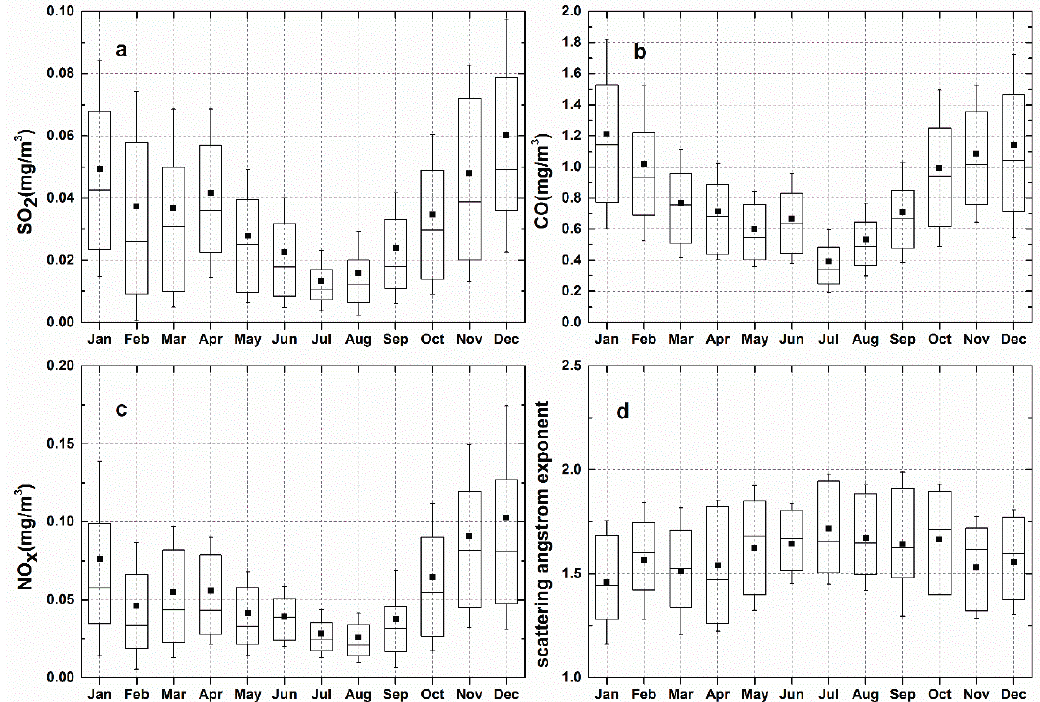
Figure 7. Box-and-whisker plots of seasonal variation of gases mass concentrations and scattering Ångström exponent. The plots illustrate the mean value (solid black square), median (horizontal bar in box), 25th and 75th percentiles (lower and upper ends of box), standard deviation (horizontal upper and lower lines): ( a ) SO 2 ; ( b ) CO; ( c ) NO x ; ( d ) scattering Ångström exponent.